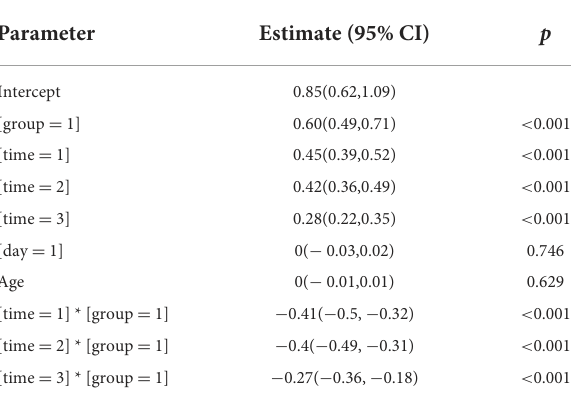
TABLE 3 Estimates of fixed effects. TABLE 4 Pairwise comparisons of time